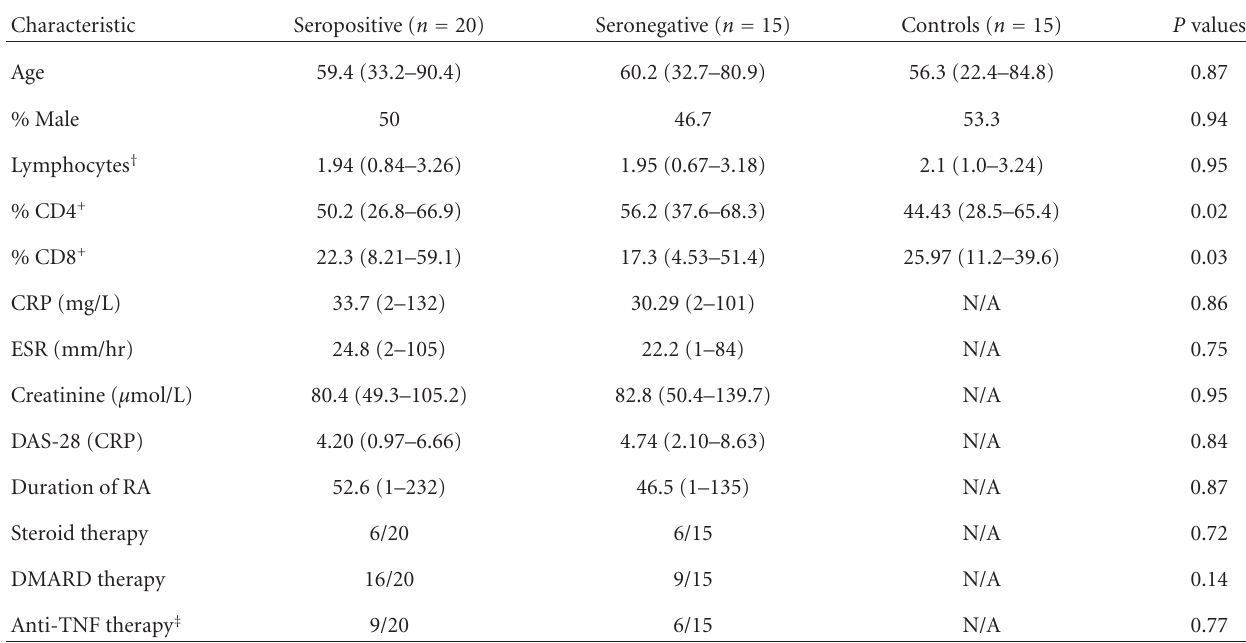
Table 1: Characteristics of the study population ∗